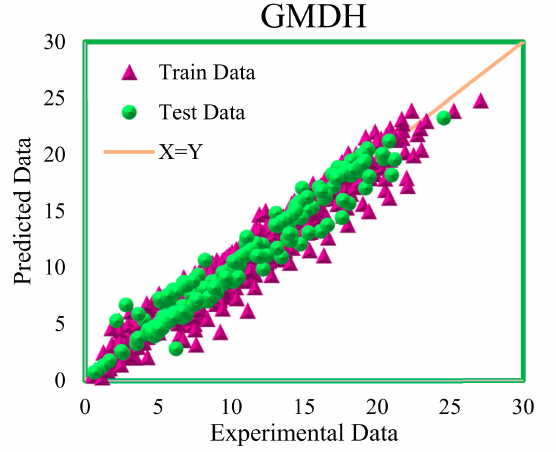
Figure 3. Cross plots of the models developed for IFT determination.